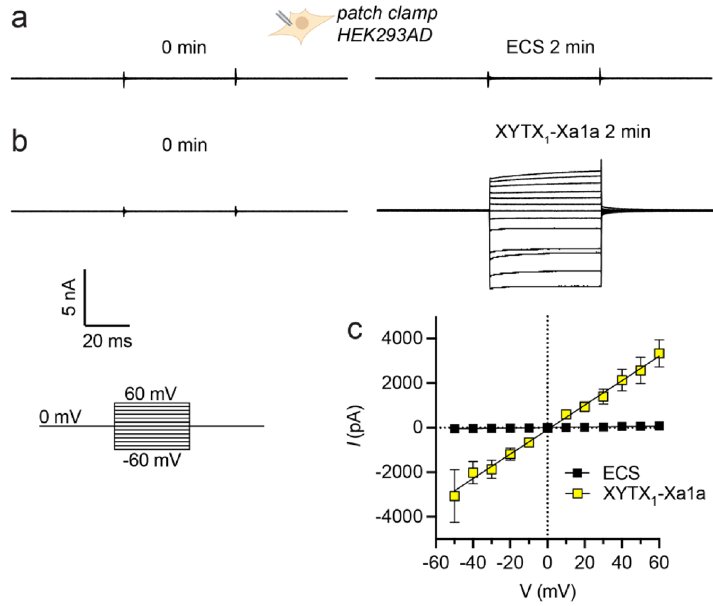
Figure 3. XYTX 1 -Xa1a causes a leak current in HEK293AD cells. ( a ) Representative current traces in HEK293AD cells at voltages of − 60 to + 60 mV (10 mV steps) acquired before application and 2 min